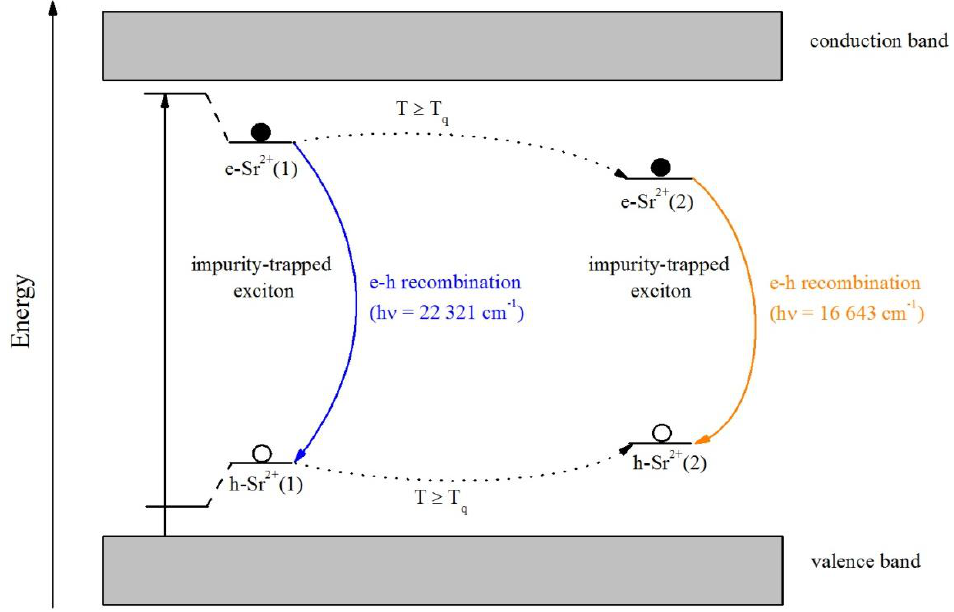
Figure 12. Proposed model for the electron transfer between the valence and conduction band in Sr 2+ -doped Ba SiO 2 4